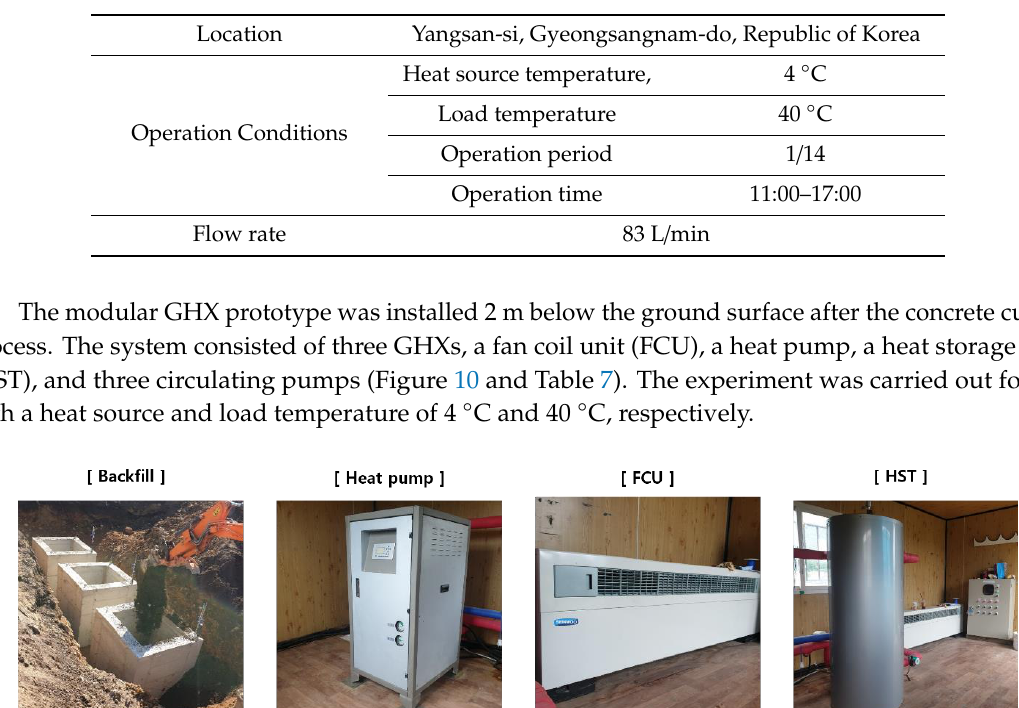
Table 6. Experiment conditions.